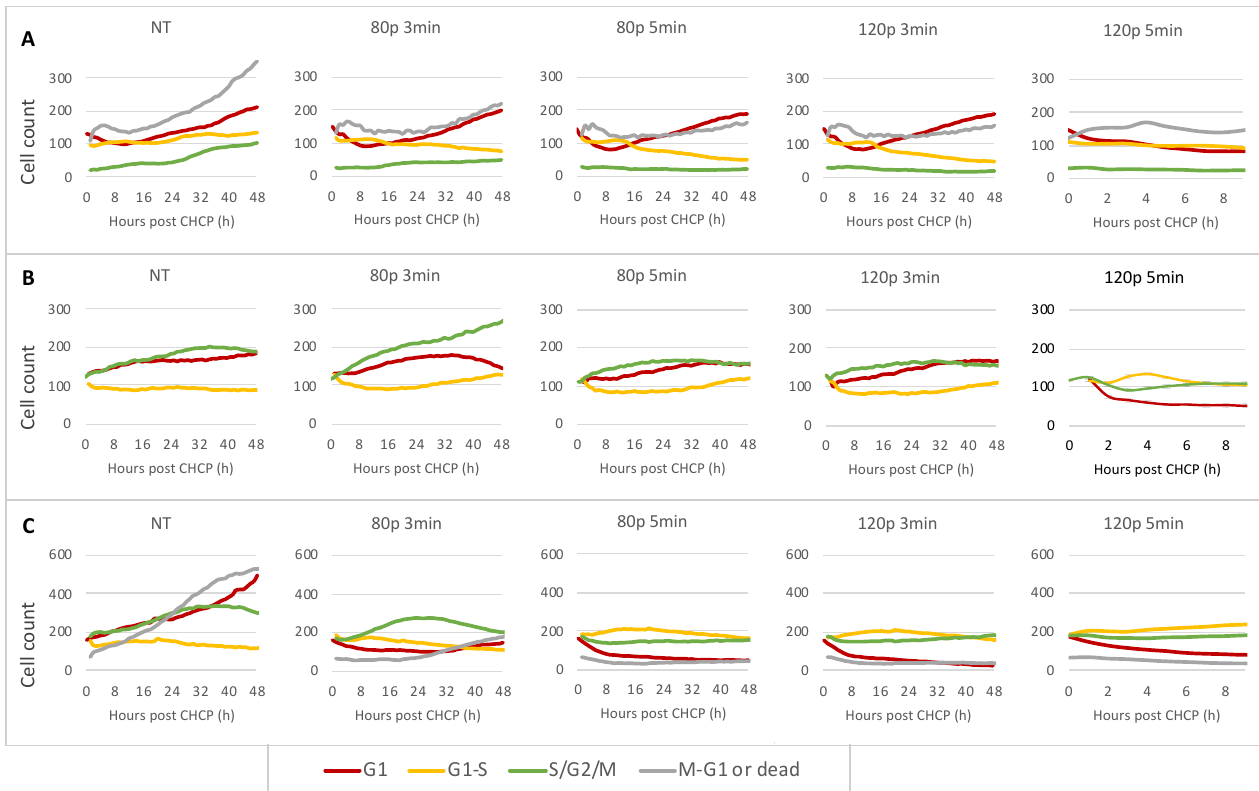
Figure 4. Quantification of ( A ) MCF-7, ( B ) BT-474, and ( C ) MDA-MB-231 cells in G1, G1-S, S/G2/M, and M-G1 phases over 72 h after CHCP treatment at various dosages.